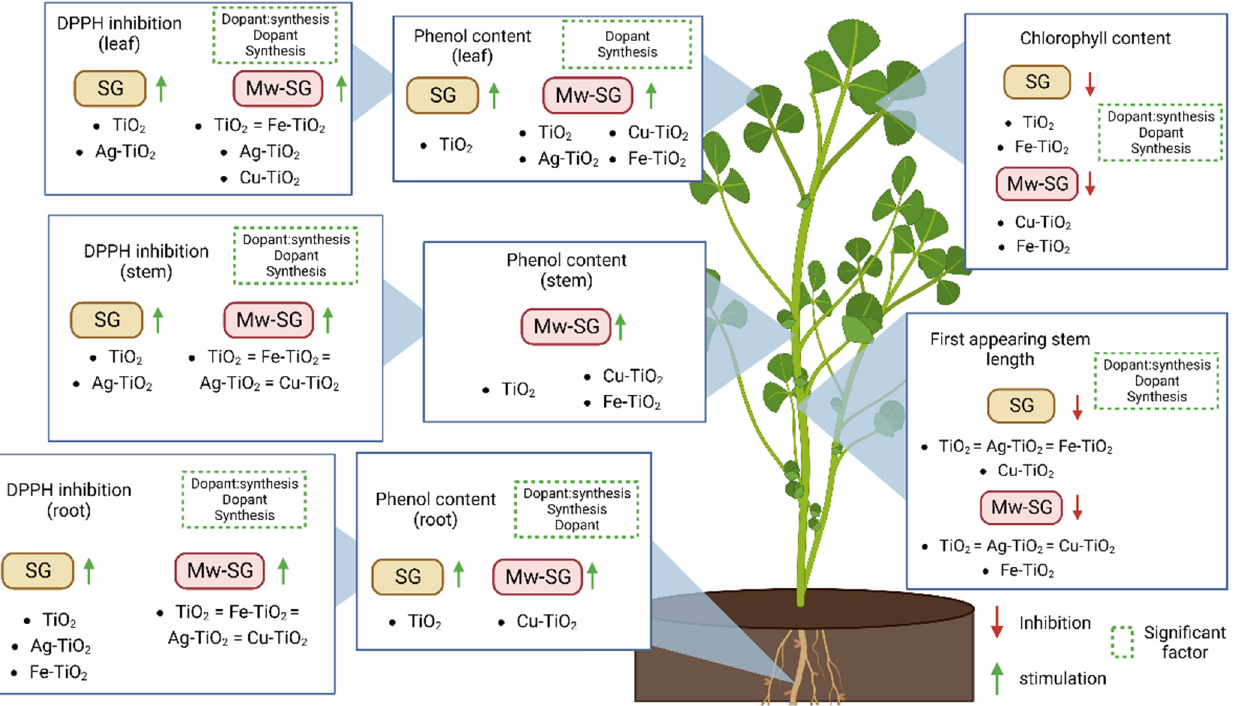
Figure 8. Résumé of the effects observed in alfalfa crops, NM treatments shown in the image caused a significant increase or reduction in the measured parameter compared to the control.